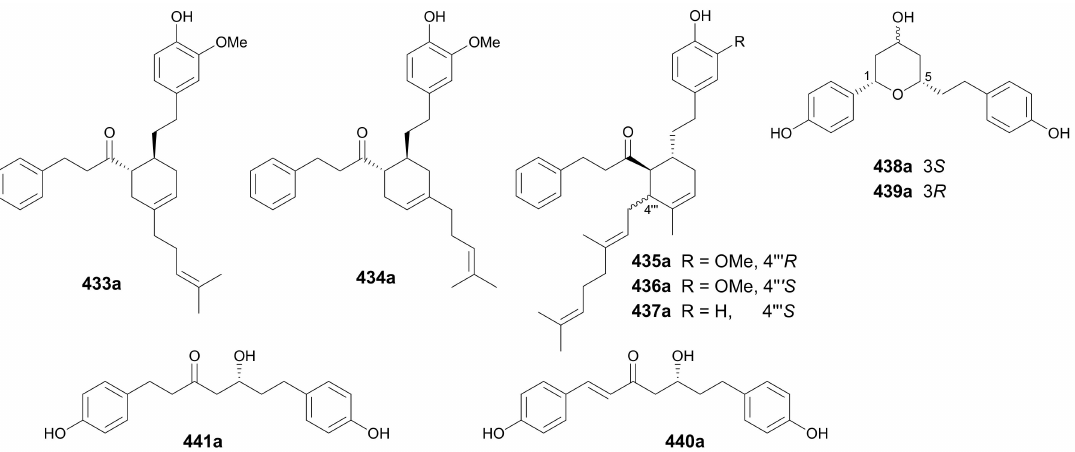
Figure 25. Structures of